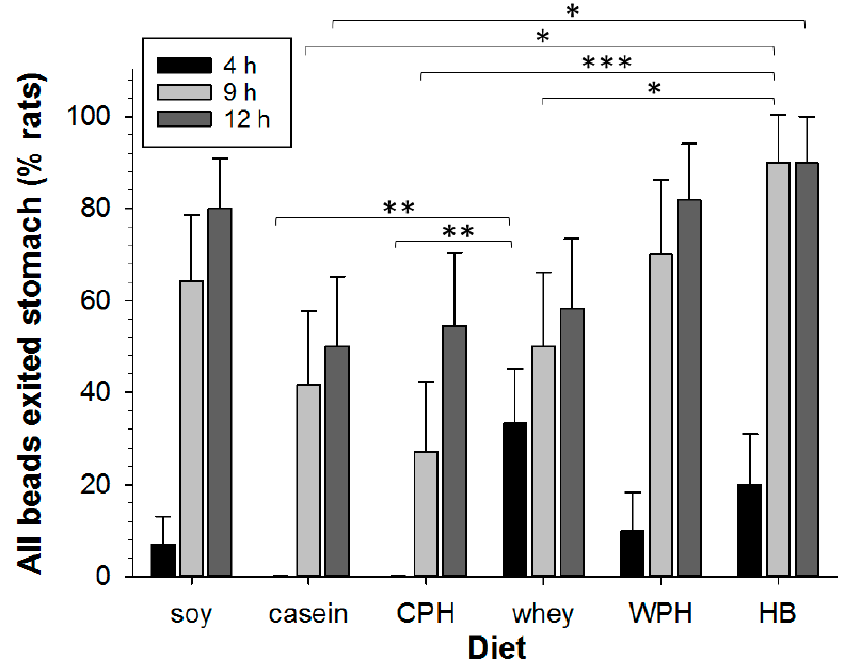
Figure 3. Comparison of gastric emptying (GE) of beads over 12 h for animals treated with soy or milk protein diets ( n = 8–15 animals per group). The percentage of rats in which all beads had exited the stomach (mean per treatment) is shown at 4 h (black), 9 h (light grey), and 12 h (dark grey) for: soy, casein, hydrolyzed casein (CPH), whey, hydrolyzed whey (WPH), and hydrolyzed blend (HB). Asterisks indicate the significance of each treatment relative to controls (* p < 0.05; ** p < 0.01; *** p < 0.001). Data show mean ± SEM.